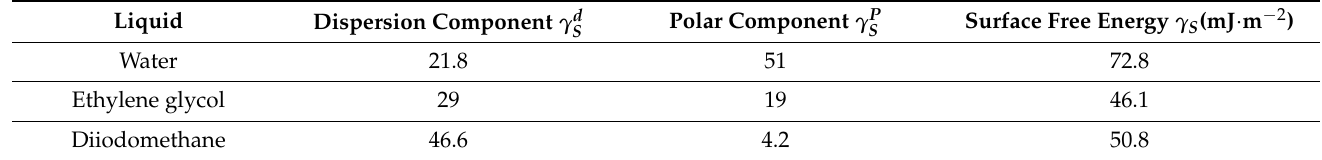
Table 1. Dispersion and polar components and surface free energy of water, ethylene glycol and diiodomethane. Liquid